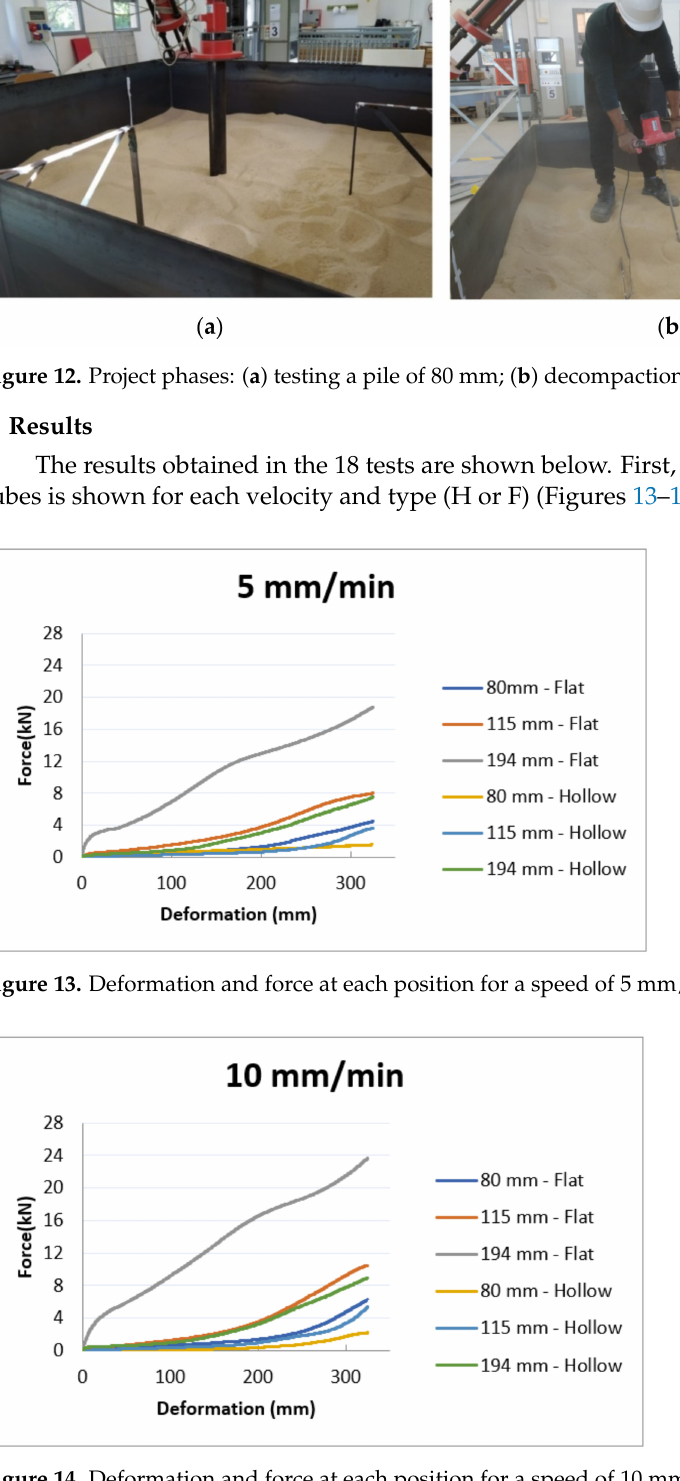
Figure 14. Deformation and force at each position for a speed of 10